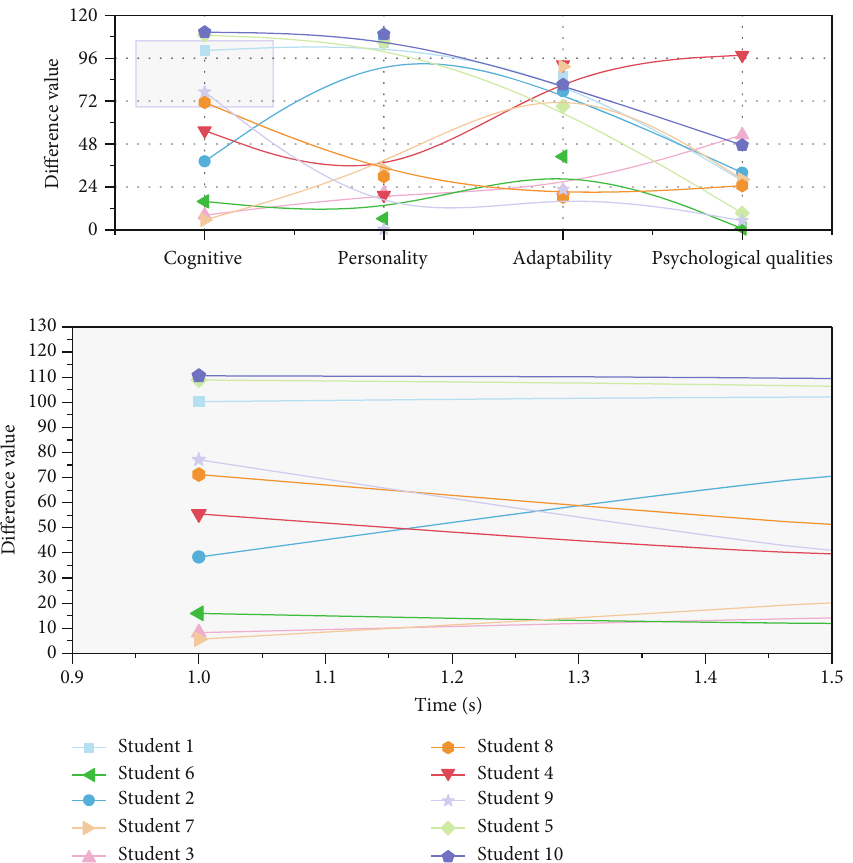
Figure 1: Di ff erences in the psychological quality of college